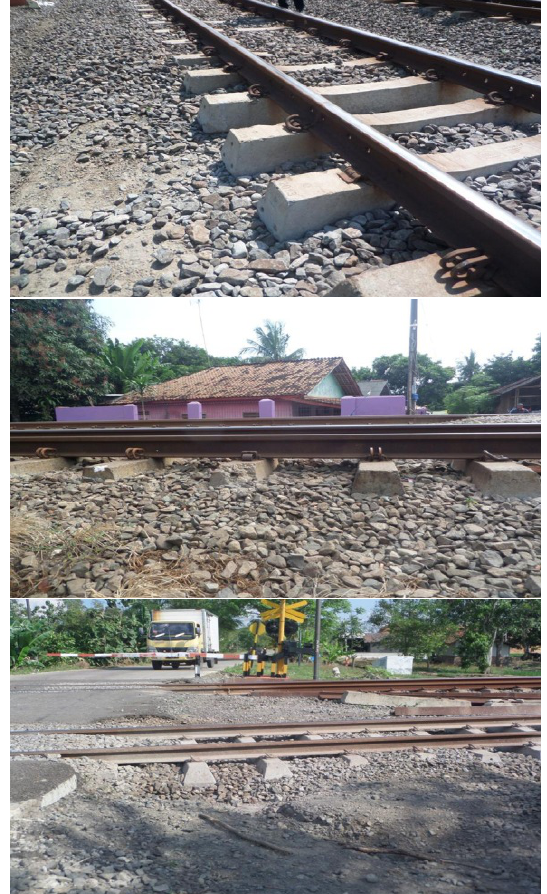
Figure 2: Ballast material